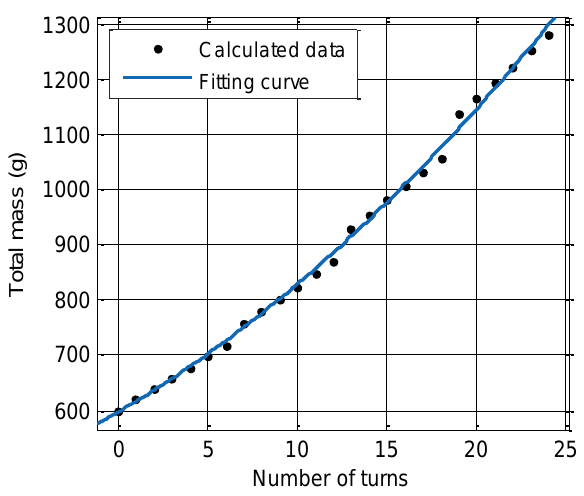
Figure 7. Weight of an inductor in function of number of turns.